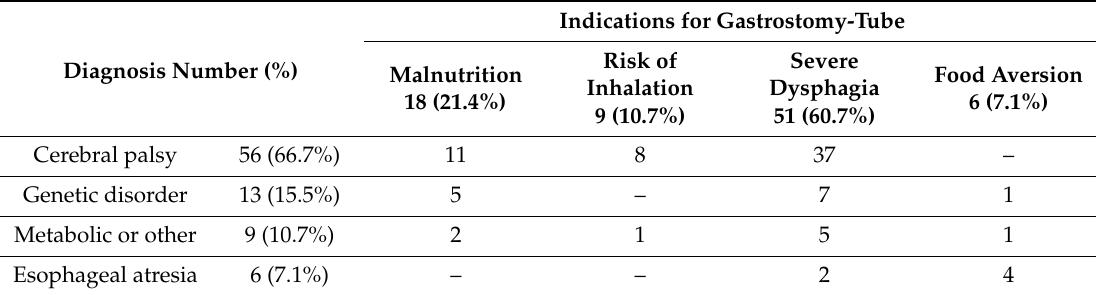
Table 1. Indication for g-tube placement related to patients’ diagnosis.